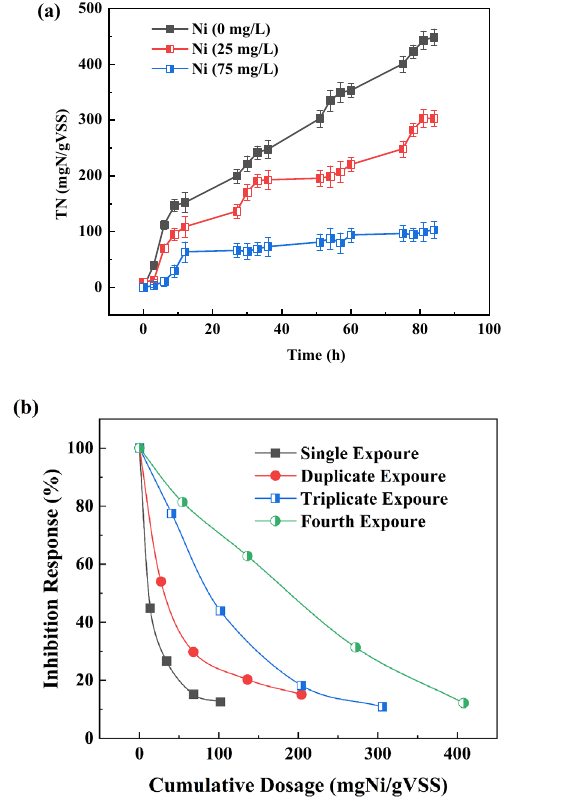
Figure 6. The cumulative TN removal with different Ni(II) addition ( a ) and the inhibition response to Ni(II) accumulated in the sludges with 25 mg/L Ni(II) addition ( b